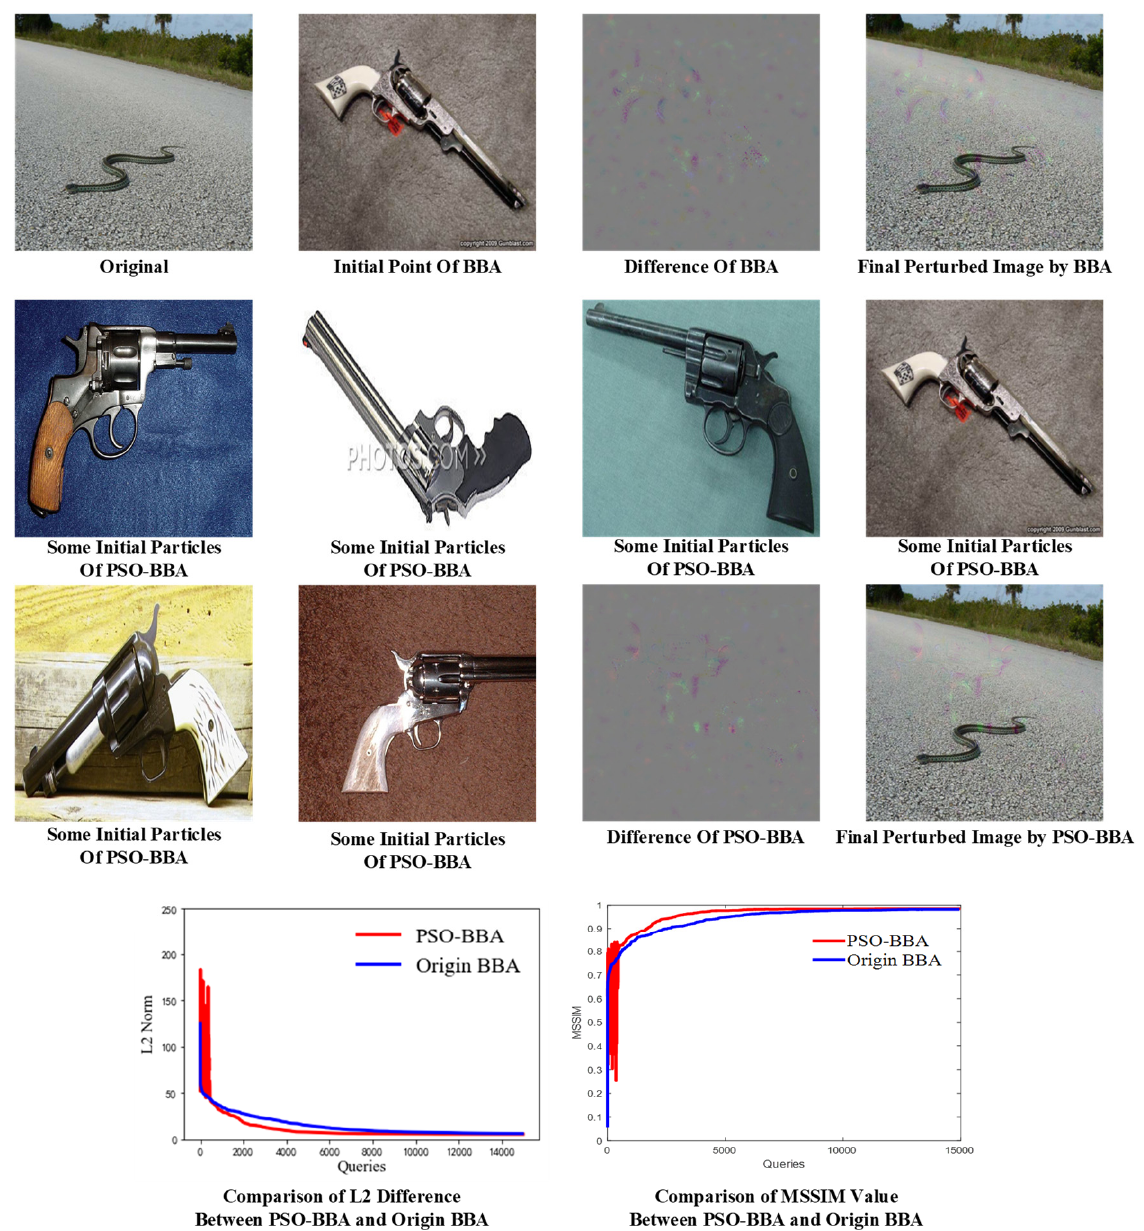
Figure 7. Comparison Experiment 1 of specific adversarial process and results between PSO-BBA and BBA.